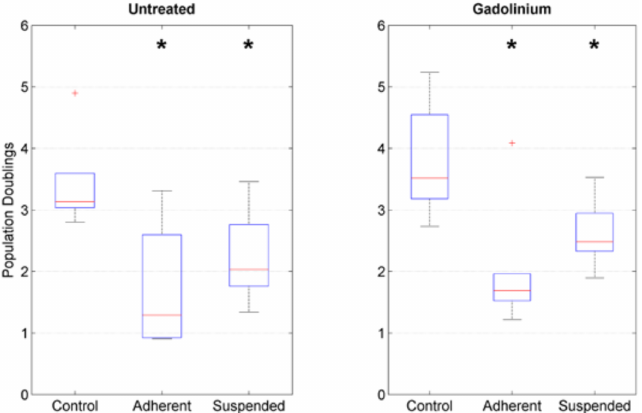
Figure 2. Cell proliferation. Population doublings were estimated by manual counting. RPM-exposed samples proliferated more slowly than control samples in monolayer culture. The box plot indicates the median (red central line), the 25th and 75th percentiles (box edges) and the most extreme data points (whiskers). Outliers are plotted individually. The asterisks indicate statistically significant difference as compared to the respective control group. The nomenclature of the samples is indicated in Figure 1.